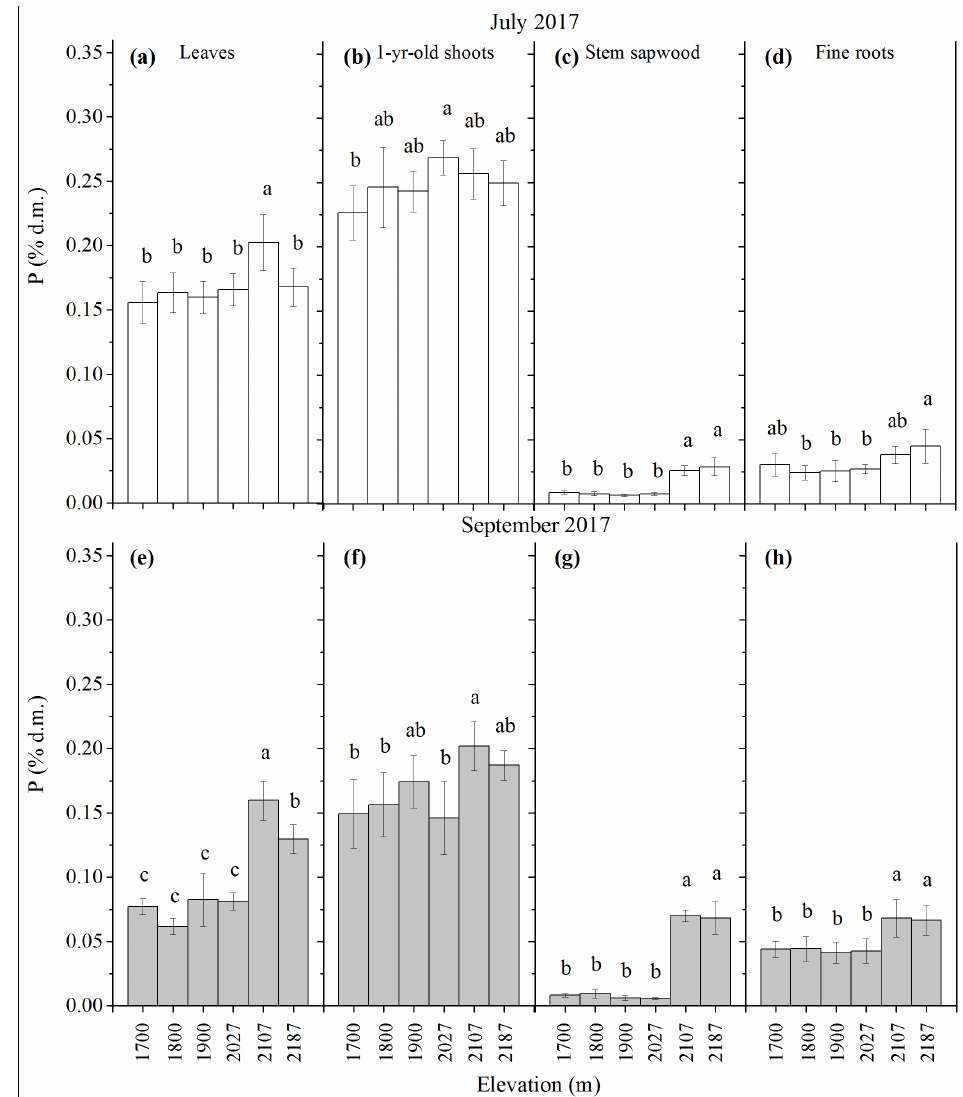
Figure 3. Seasonal tissues concentration (Mean ± 1SD; % of dry matter) changes in total phosphorus (P) of Betula ermanii trees along elevational gradients in Changbai Mountain ( n = 5 for each elevational site and tissue type). Different letters display significant differences at the 0.05 level among elevations as determined by Tukey’s HSD test.